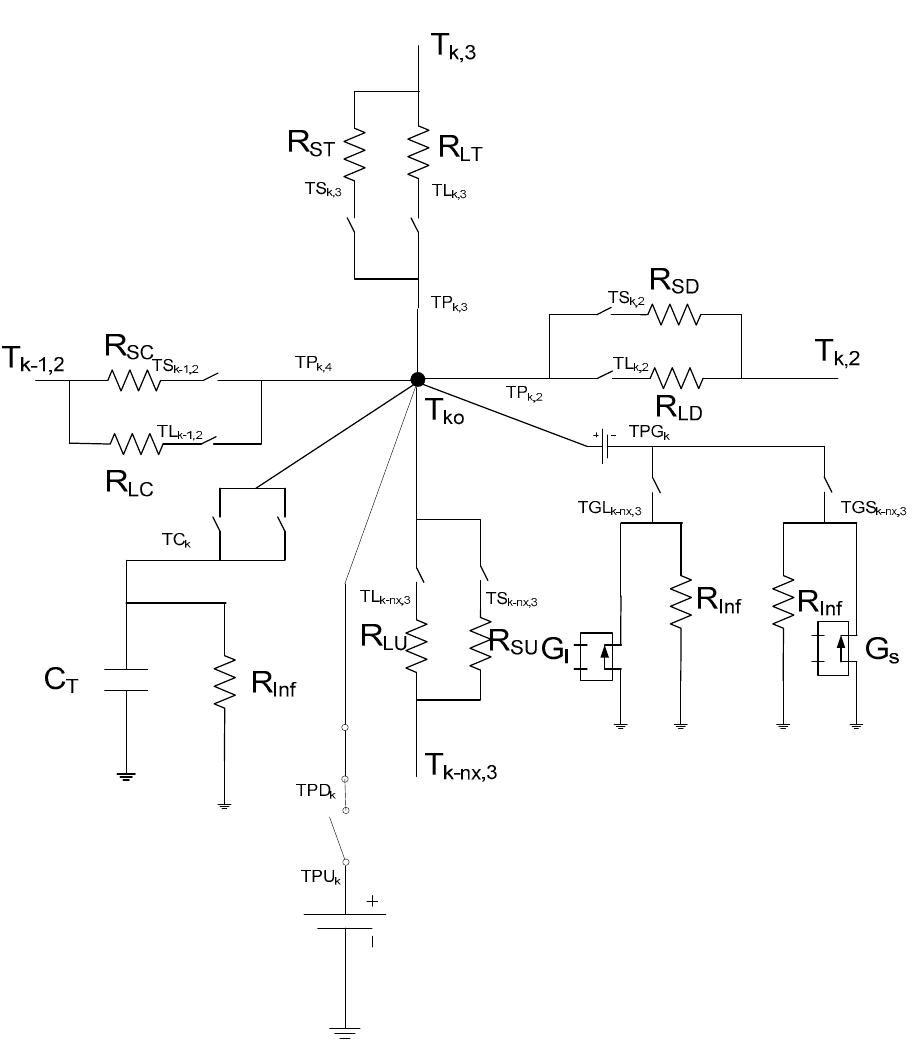
Figure 4. Network model for cell k.